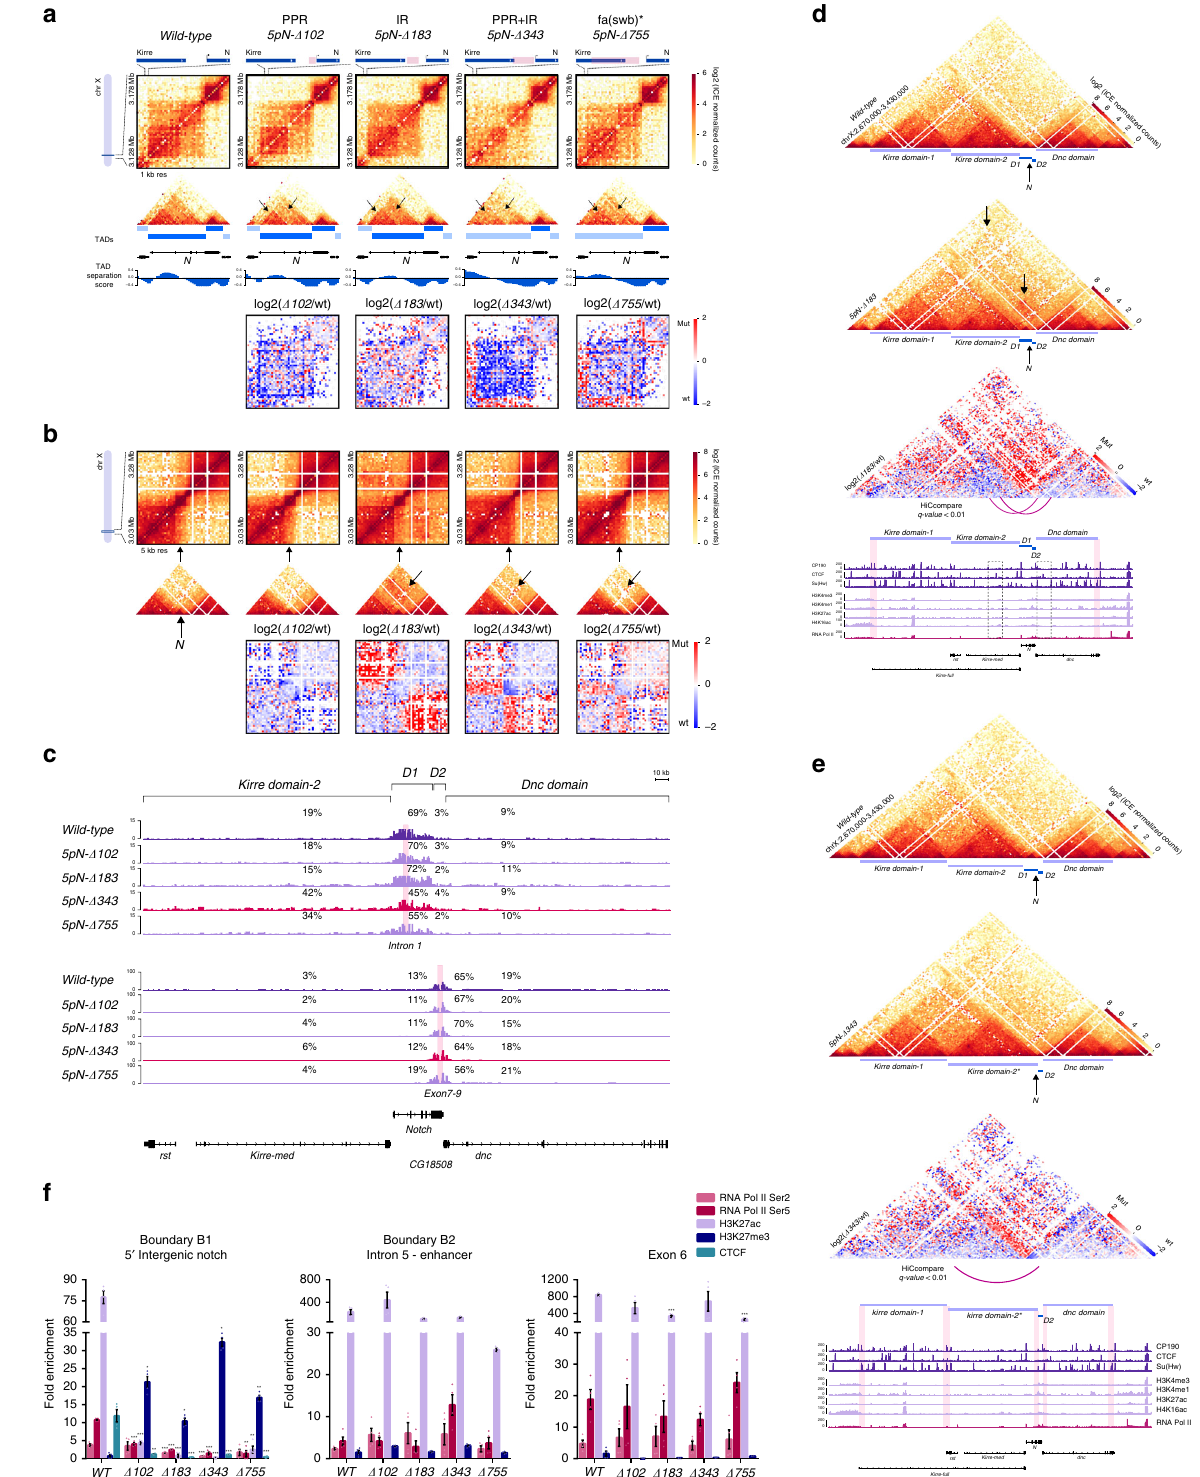
interactions with the D1 domain concomitant with a gain of ectopic interactions with the upstream kirre domain-2 (Supple- mentary Fig. 6e). However, this trend is not observed when additional viewpoints within the D1 domain are analyzed (Fig. 2c). Despite observed topological effects, the removal of the PPR is not suf fi cient to induce the fusion of the D1 domain and the upstream kirre domain-2